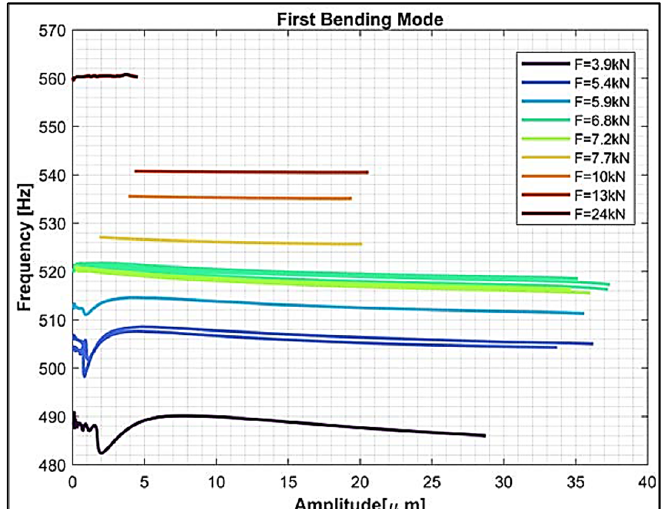
Figure 10. Frequency as a function of vibration amplitude for first flexural mode. Regarding the second flexural mode, variations of damping and frequency with re- spect to the vibration amplitude are shown in Figure 11. According to this, an initial stretch of constant damping is observed for small vibration amplitudes. Then, a steep growth is evident beyond a critical amplitude at which the sliding begins. Considering the same traction force, the critical amplitude depends upon the effective I_RMS current sent to the shaker. This current defines the amplitude of oscillation of the exciting force before the detachment of the shaker tip from the beam, and therefore the amplitude of the vibration at the beginning of the free decay. Close examination of the figure suggests that the highest damping is achieved when a traction force of approximately 8 kN is exerted to the beam, and more intense loading results in a drop in damping. Besides, a decrease in the critical amplitude is observed as the traction force increases, the phenomenon also presents in the first flexural mode. The dependence of the frequency on the vibration amplitude is also illustrated in Figure 11, where the frequency follows a constant trait for low amplitude values, revealing the complete adhesion at the contact regions. Stiffening effect, already identified for the first bending mode, can be recognized from the frequency trend against the traction force. ( a )